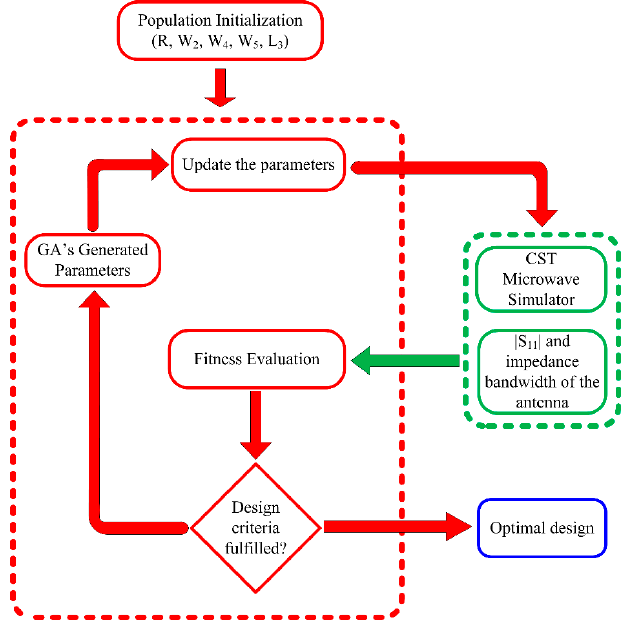
Figure 3. Flow chart explaining the working of genetic algorithm utilized to optimize the antenna.